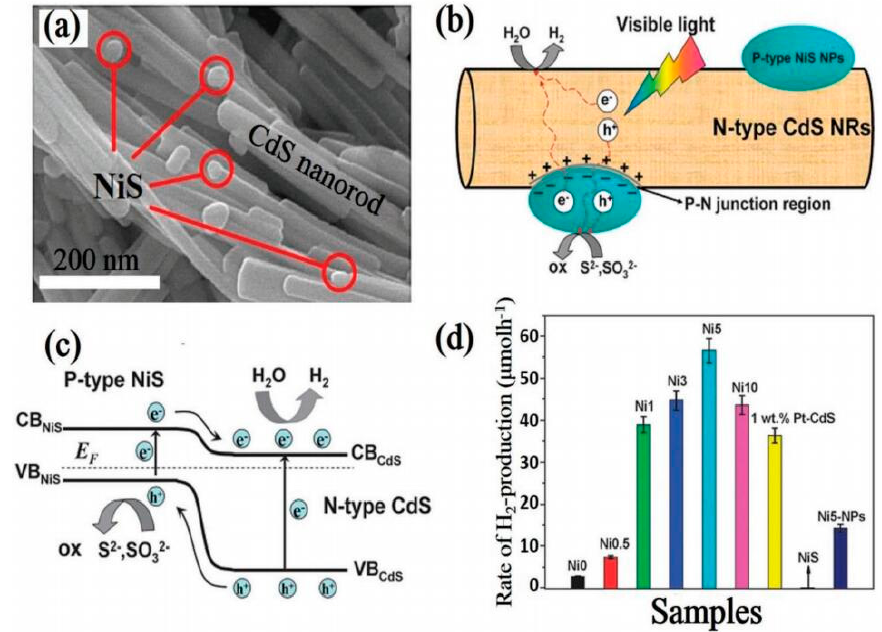
Figure 14. ( a ) SEM image of CdS/NiS composite catalysts; ( b , c ) illustration of electron–hole pairs with CdS/NiS composite photocatalysts; ( d ) contrast of photocatalytic efficiency of CdS with different NiS content. Reproduced with permission from Reference [105]; copyright (2017), John Wiley & Sons, Inc.